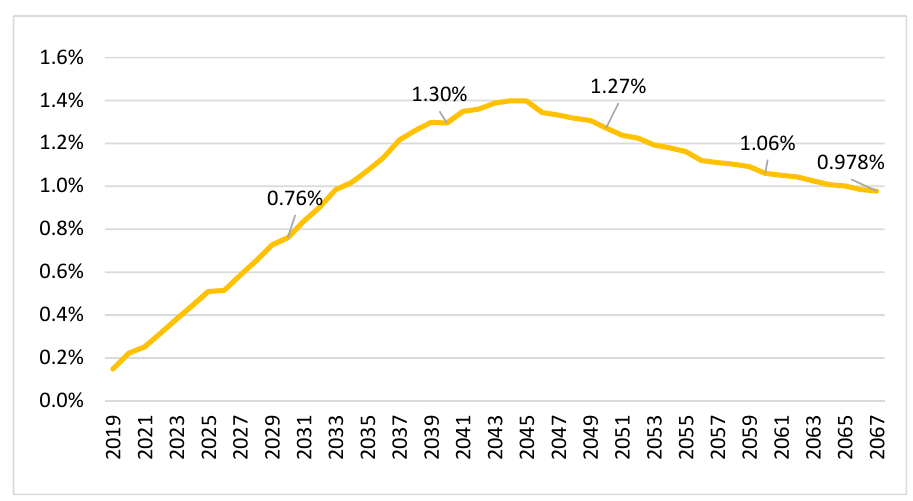
Figure 8. Savings in PAV / GDP each year with the application of the SF. Source: Own elaboration. 7. Sensitivity Analysis of the Working Hypotheses and the E ff ect of Delaying the Application of